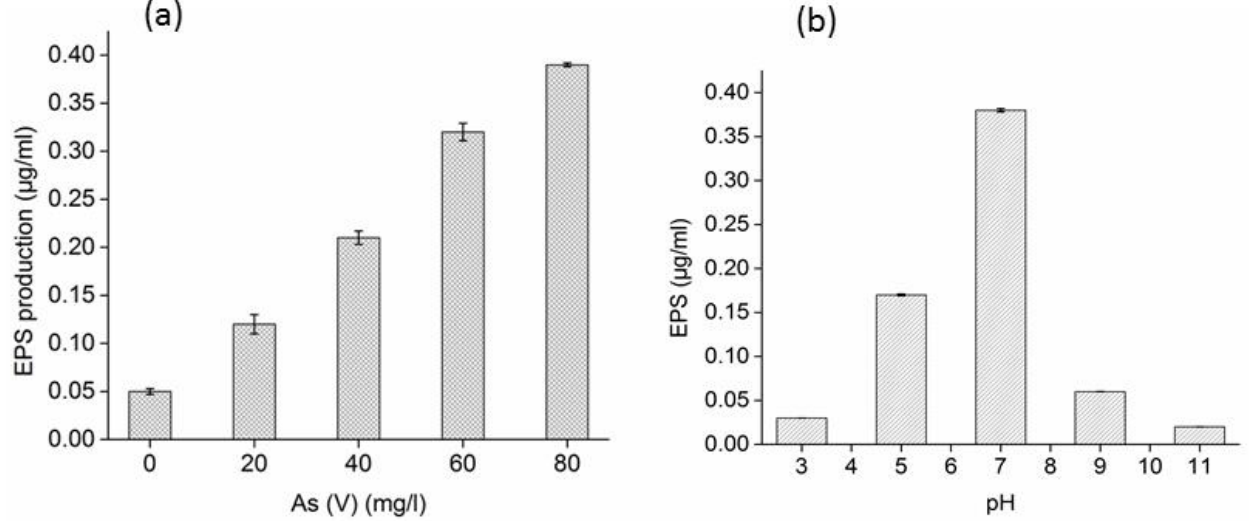
Figure 1. ( a ) EPS production by Bacillus XZM at different at arsenic concentrations and ( b ) pH. Note: Mean ± Standard deviation (n = 2); in ( b ), As(V) level of 50 mg/L was selected based on ( a ).